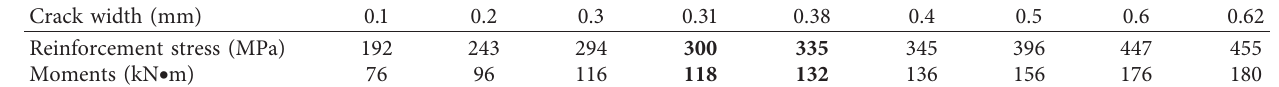
Table 4: Relationships among crack width, stress of the reinforcements, and moments of the segments.